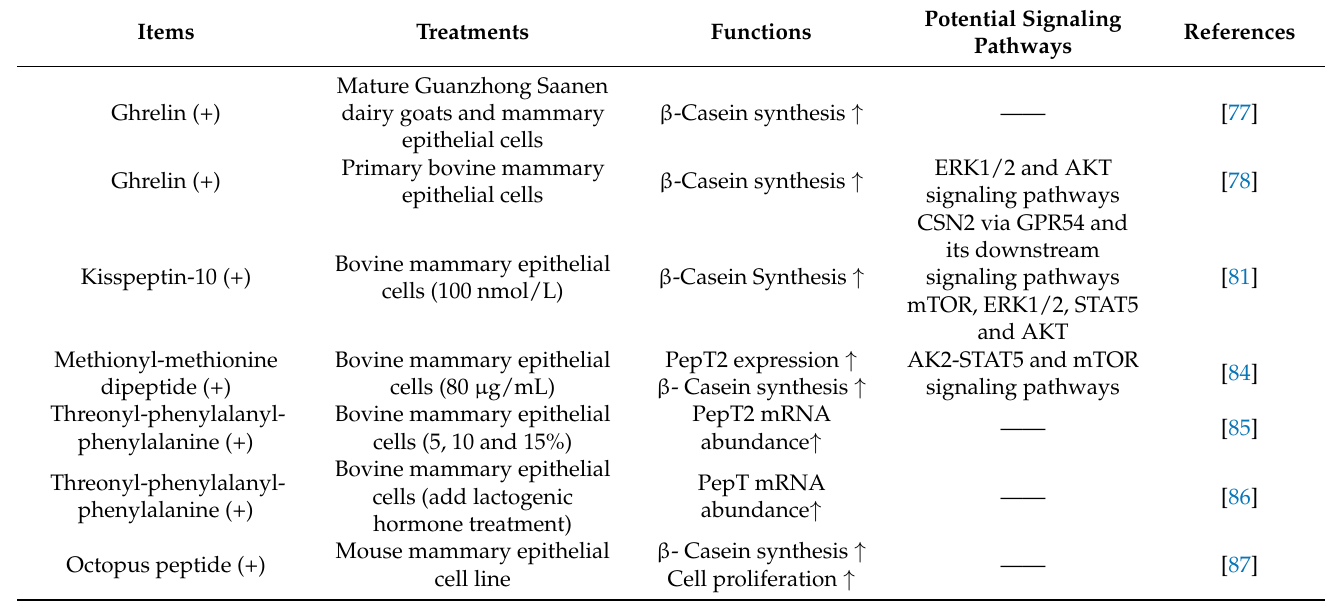
Table 2. Effects of peptides on milk production and its potential regulatory